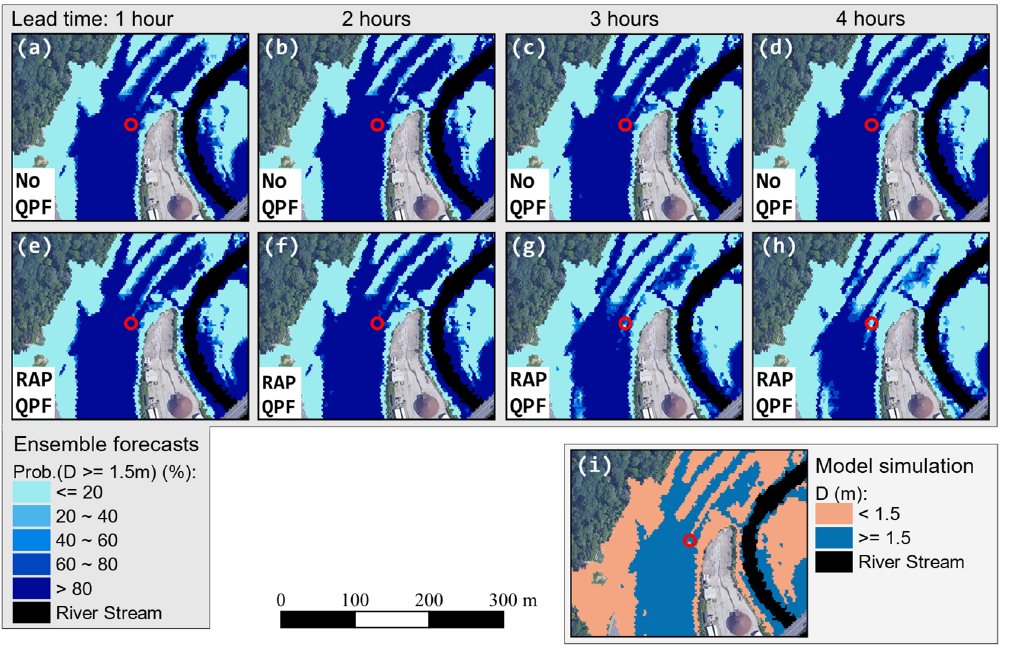
Figure 12. Inundation maps forecasted by the surrogate models without QPF ( a – d ), with QPF ( e – h ), and simulated by the hydrodynamic model ( i ) at the peak water level of the event of 8 July 2013, at POI 1 (red circle in the maps).